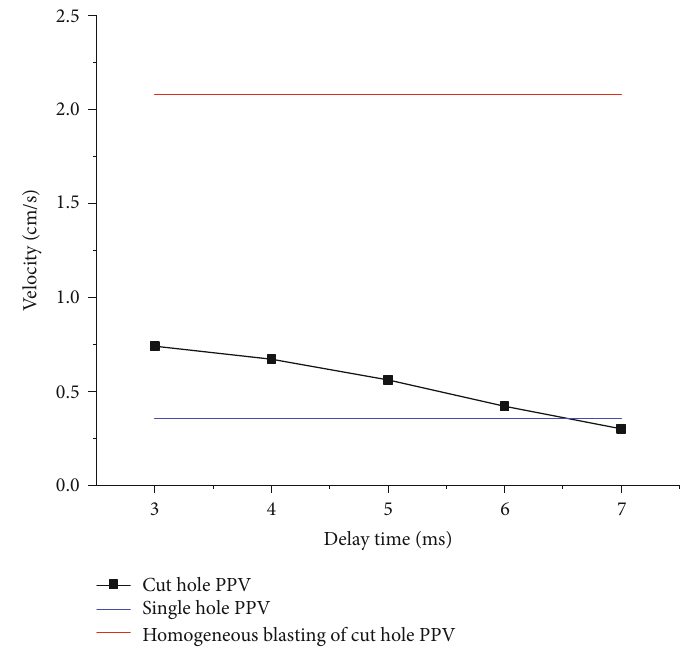
Figure 11: Statistics of blasting peak vibration velocity in cut area under di ff erent delay